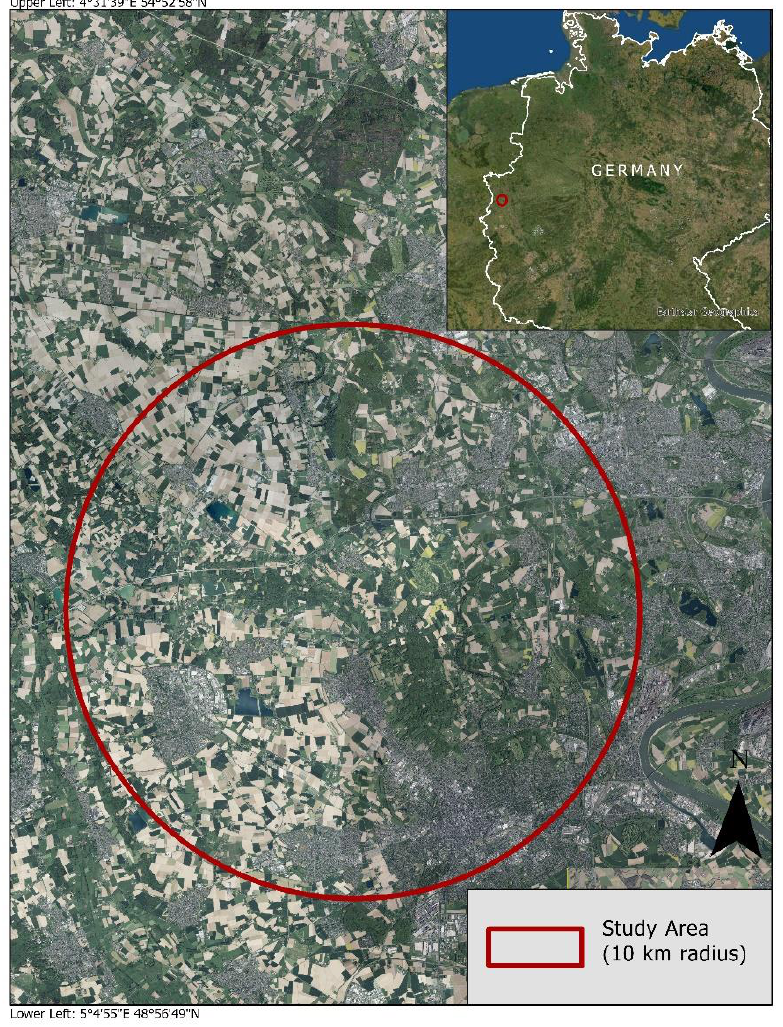
Figure 1. Study area spanning a 10 km radius around insect trap locations near Krefeld in Orbroicher Bruch Nature Reserve in North Rhine-Westphalia, Germany.